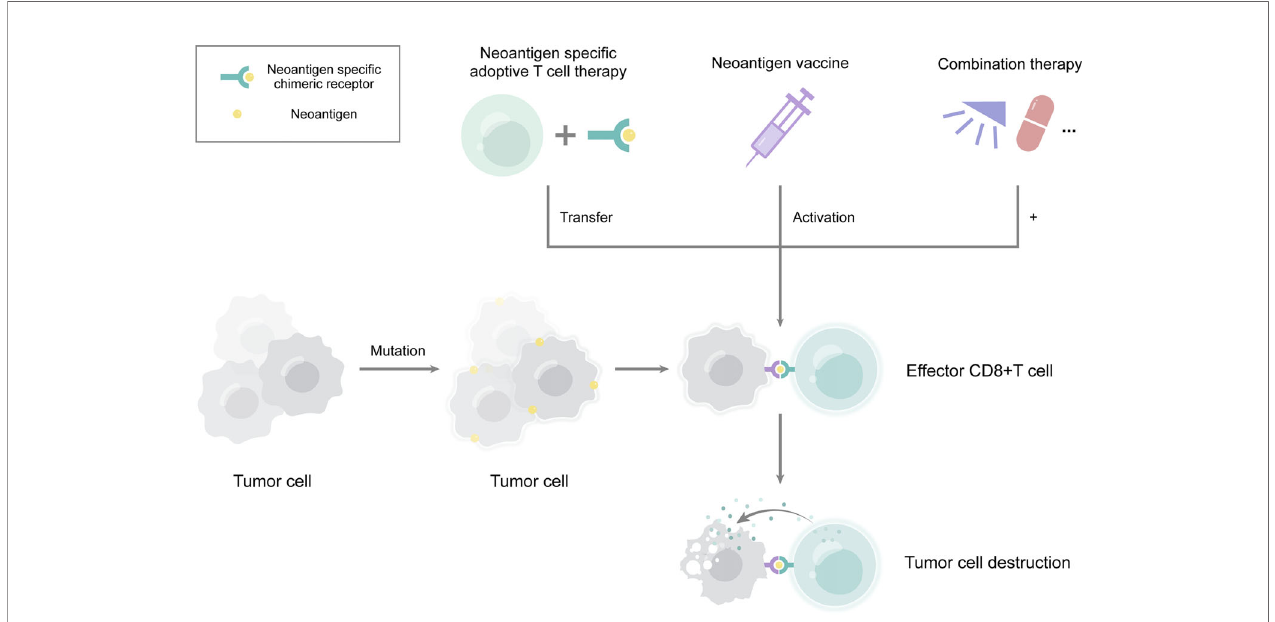
FIGURE 1 | The major clinical application of neoantigens in esophageal cancer. Neoantigens derived from mutations in tumor cells. They can serve many purposes, including neoantigen vaccination, neoantigen speci fi c adoptive T cell therapy, and combination therapy. Combinations of neoantigens with radiotherapy, chemotherapy, or immune checkpoint inhibitor therapy may lead to a better effect. Neoantigens induce the production of effector CD8+ T cells, thereby eliminating tumor cells.